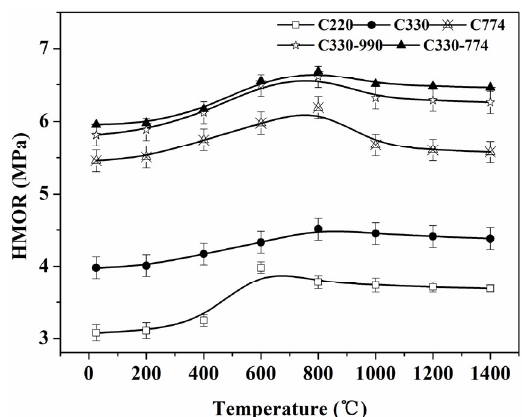
Fig. 4 Hot modulus of rupture of specimens with different types of carbon